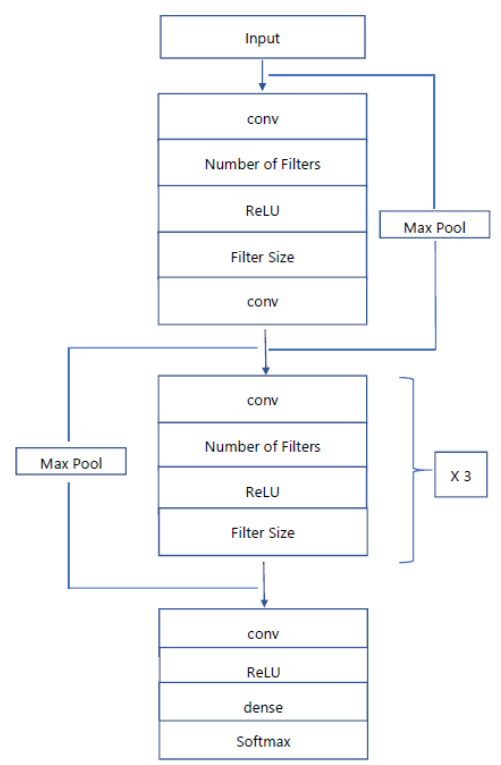
Figure 4. Proposed Algorithm of Convolution NN. Four convolutional layers were used. In addition, there is one output layer with a softmax layer to hold the output of the